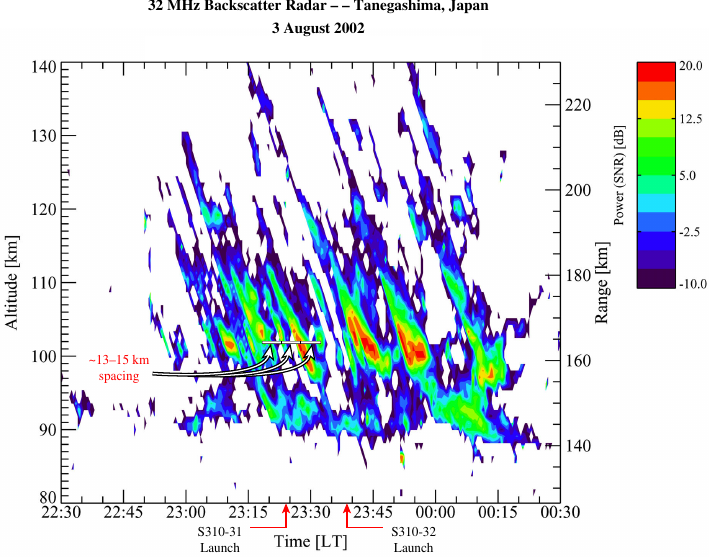
Fig. 14. Range-time-intensity plot of 32MHz radar echoes from Tanegashima (south) showing QP echo structure (Saito et al.,